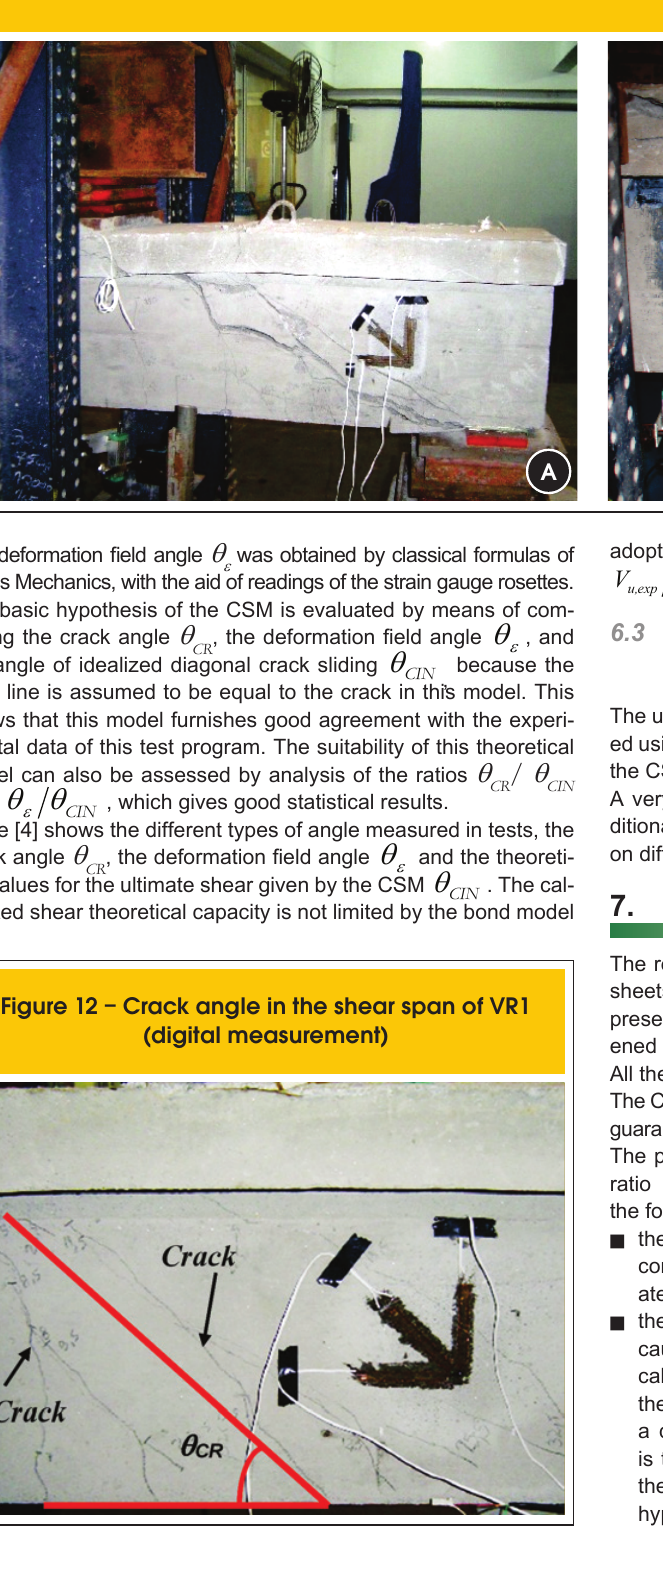
BFigure 11 – Beam failure: a) VR2; b)